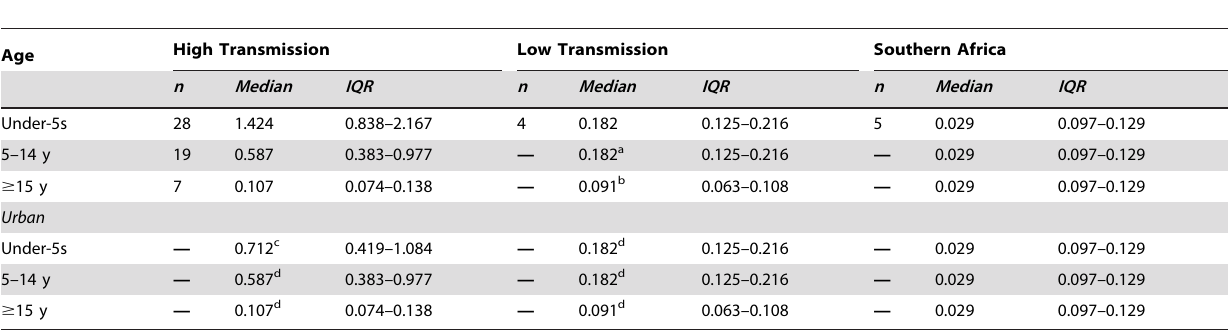
Table 2. Malaria case-incidence rates by transmission risk category (cases per 1,000 per year) used in estimating the number of cases by Method 2.